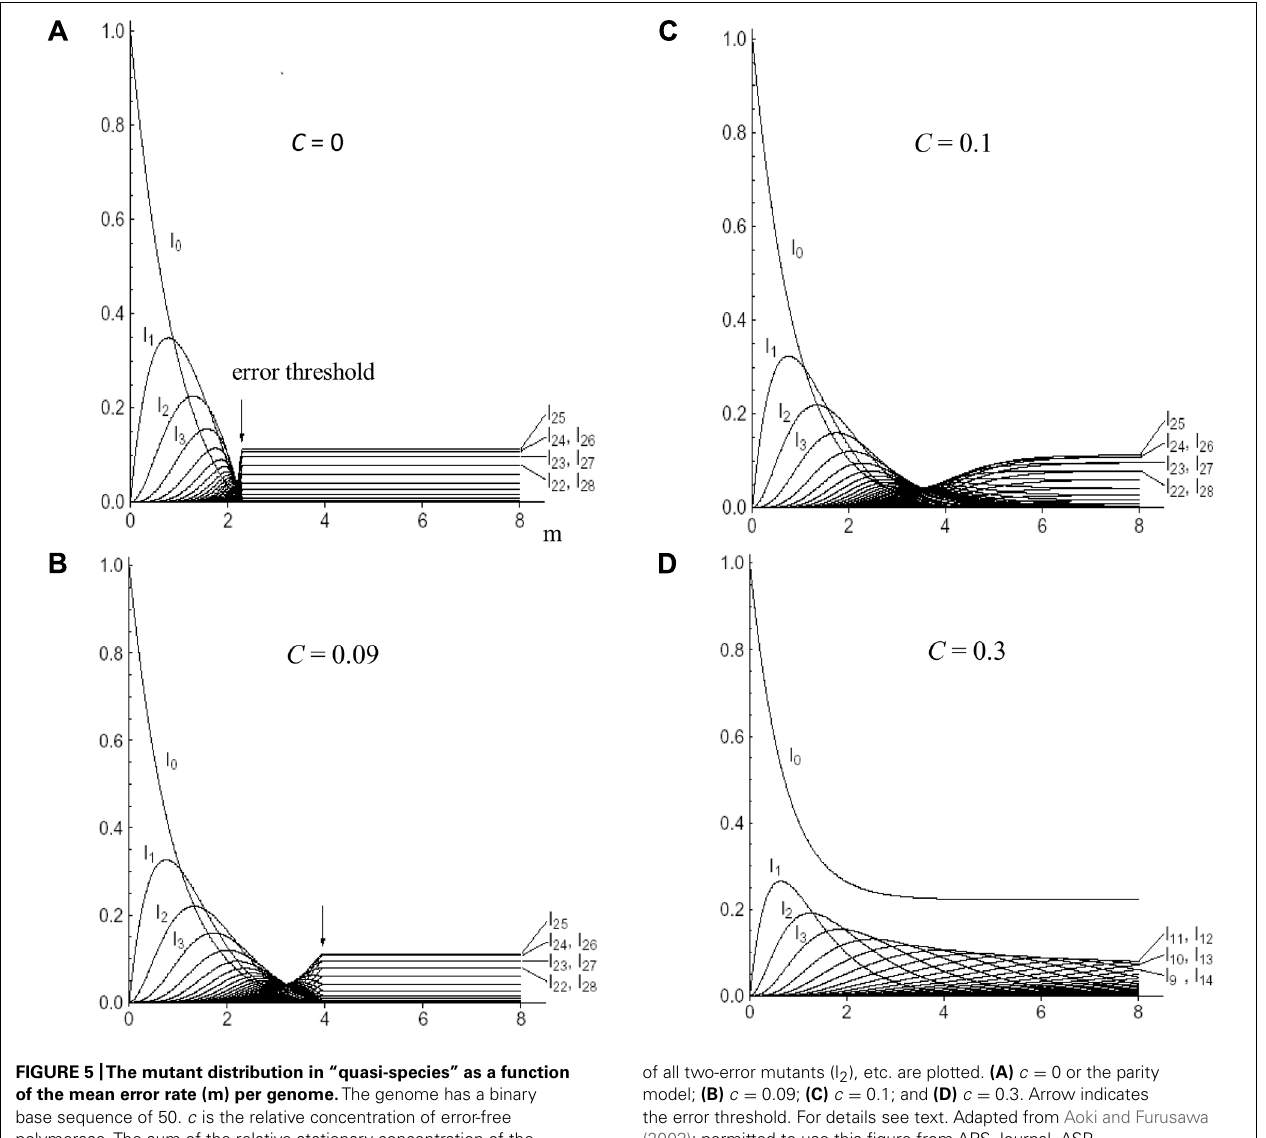
FIGURE 5 |The mutant distribution in “quasi-species” as a function of the mean error rate (m) per genome. The genome has a binary base sequence of 50. c is the relative concentration of error-free polymerase.The sum of the relative stationary concentration of the wild-type sequence with zero-mutations (I 0 ), of all one-error mutants (I 1 ),